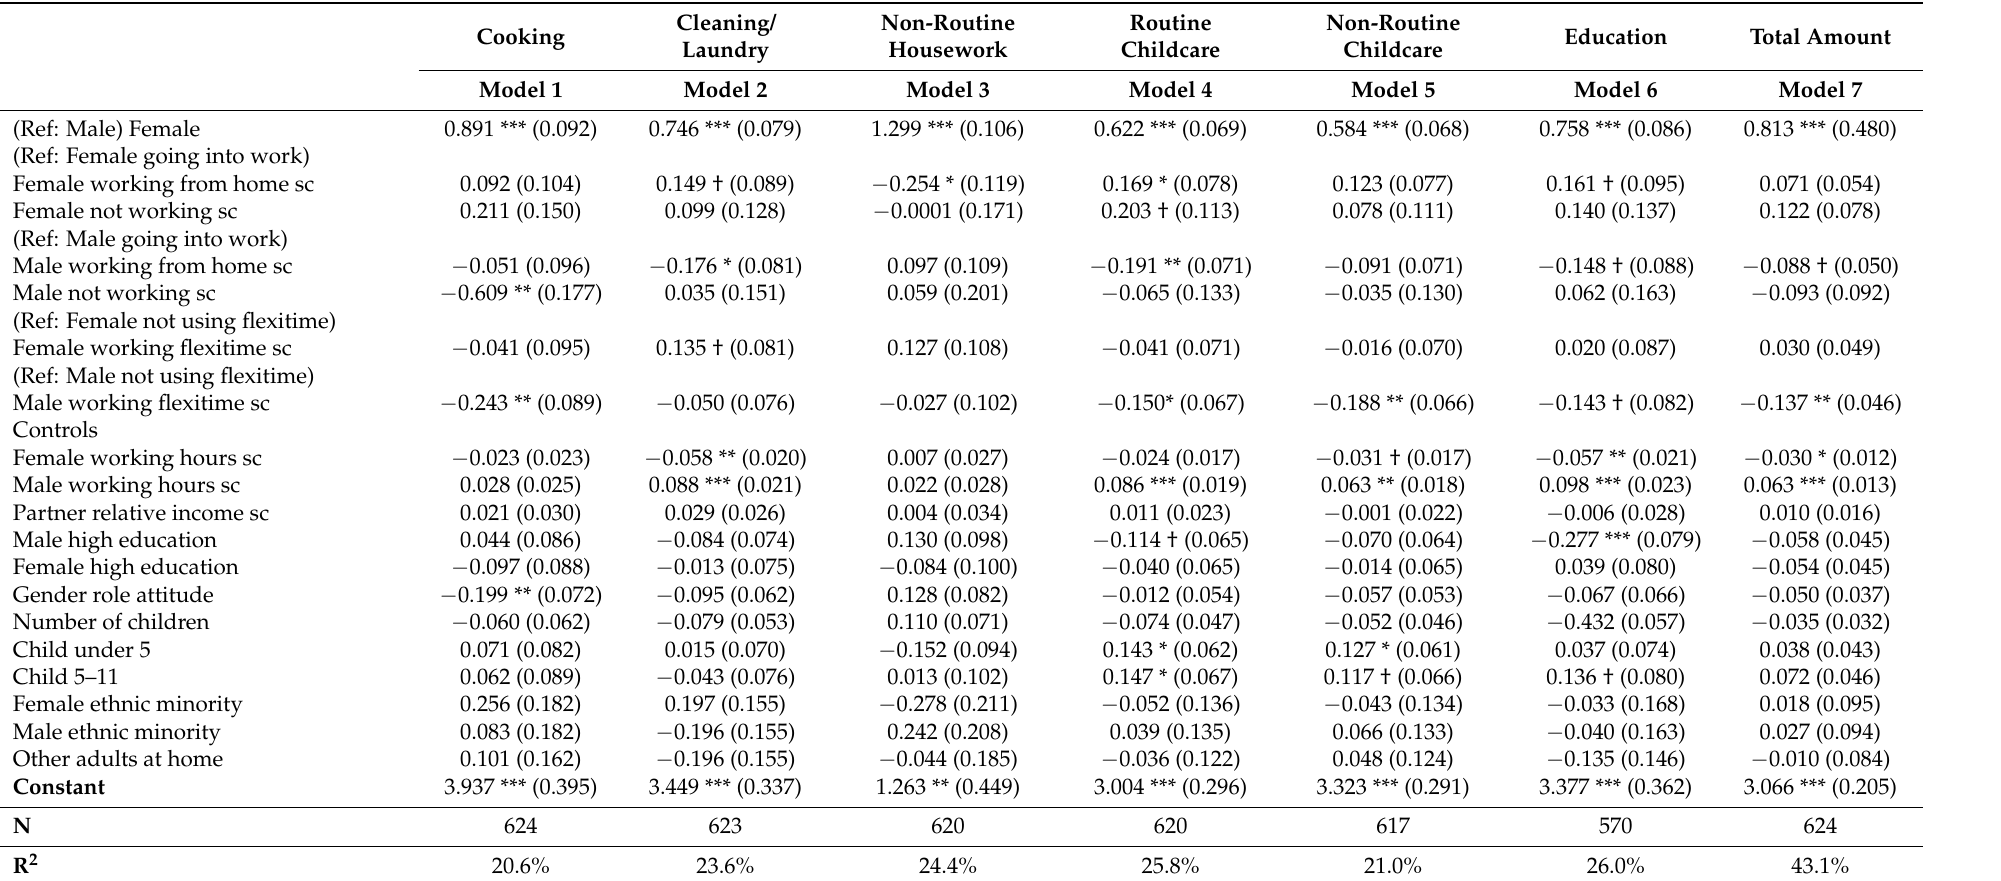
Table 1. Model explaining the division of housework and childcare during the COVID-19 lockdown for heterosexual dual earning couples with children under 18.